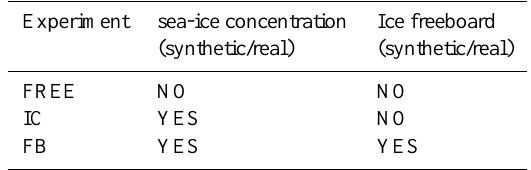
Table 2. Description of the simulations carried out with synthetic observations and real data